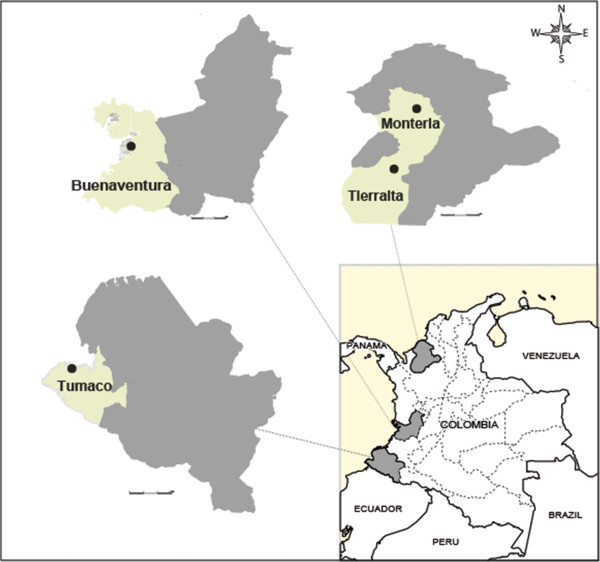
Geographical location of sites participating in the field study.